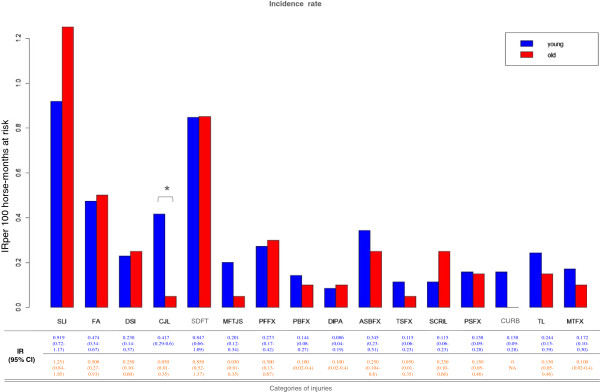
Estimated IRs for injuries by age groups. Histogram of estimated IR for categories of injuries in a cohort of harness STBR, by categories of injuries in the groups of young (<4 years old) and adult (>4 years old) horses.